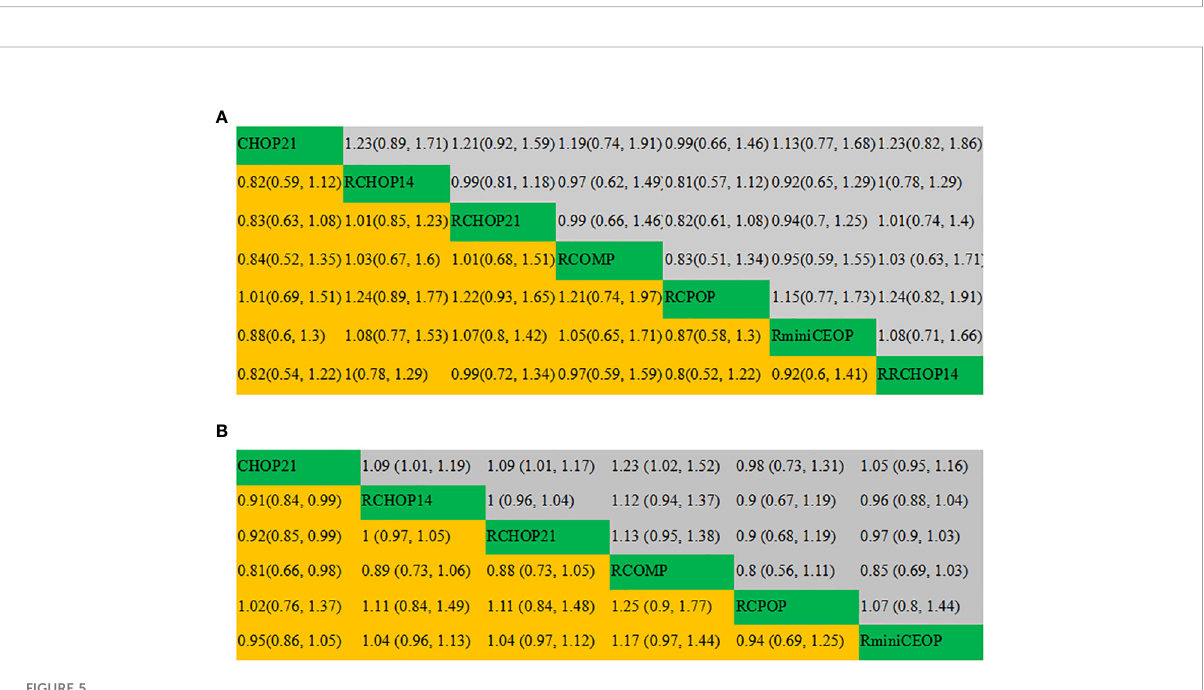
FIGURE 5 league table of (A) complete response, (B) overall